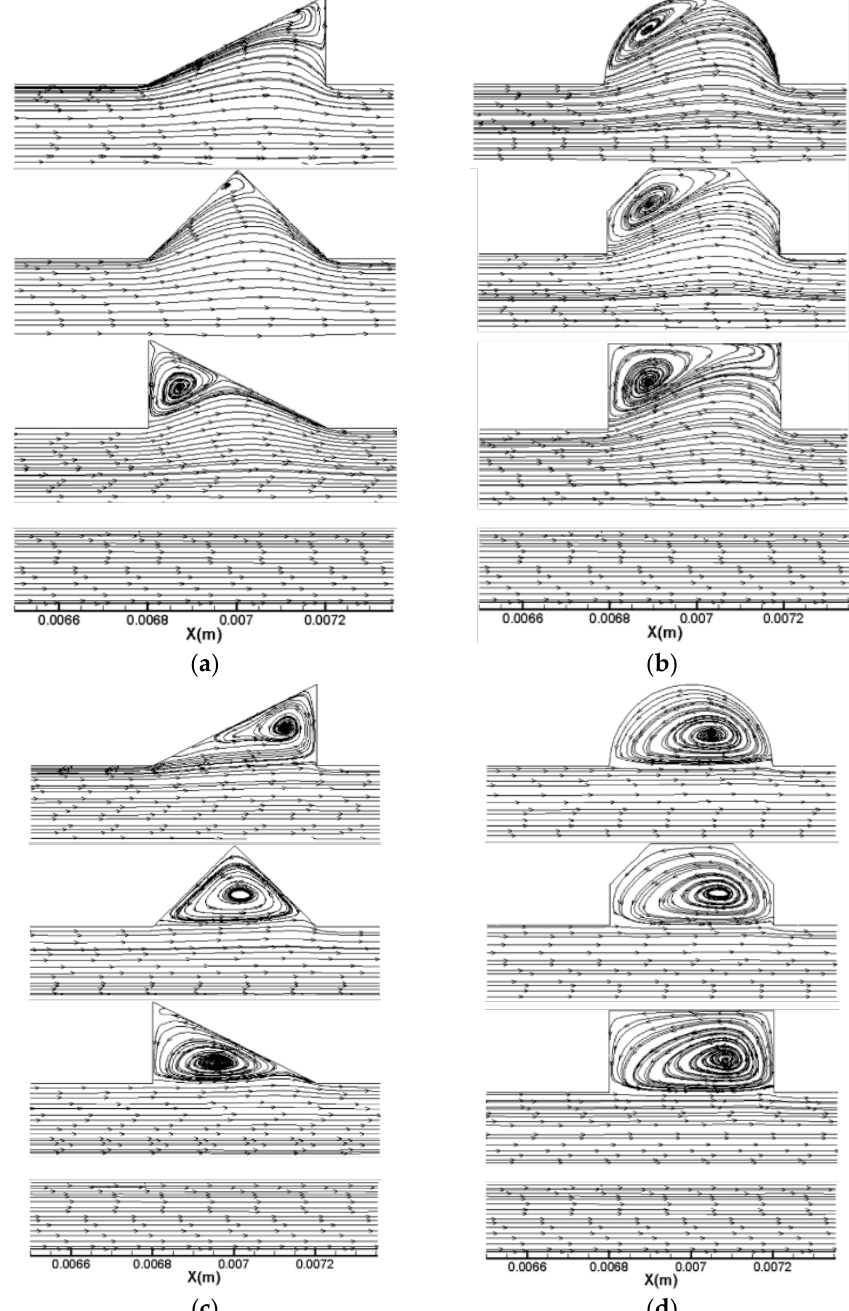
Figure 6. Streamlines in a heat sink for Re = 20 and Re = 400. ( a ) Re = 20 Group 1, ( b ) Re = 20 Group 2, ( c ) Re = 400 Group1, ( d ) Re = 400 Group 2.